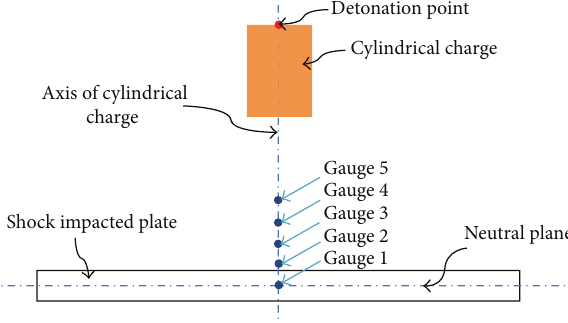
Figure 10: Locations of pressure gauges